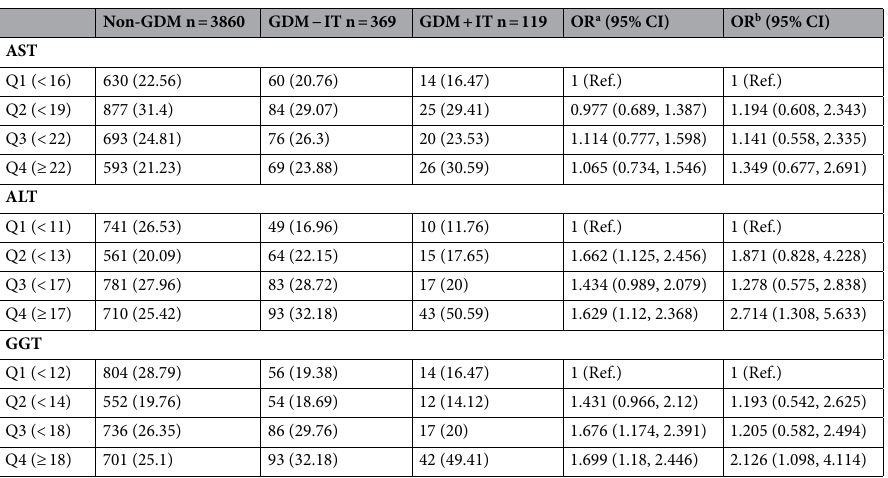
Table 2. Adjusted Odds ratios for developing GDM − IT and GDM + IT in women with twin pregnancy according to pregravid liver enzyme levels. Adjusted for maternal age, parity, smoking, alcohol consumption, income level, exercise status, BMI, and metabolic syndrome. a ORs between non-GDM group and GDM − IT group. b ORs between non-GDM group and GDM + IT group. ALT alanine aminotransferase, AST aspartate aminotransferase, GDM gestational diabetes mellitus, GGT gamma-glutamyltransferase, OR odds ratio, CI Confidence interval, Q quartile. Non-GDM pregnant women without GDM, GDM − IT GDM pregnant women without insulin treatment, GDM + IT GDM pregnant women with insulin treatment.